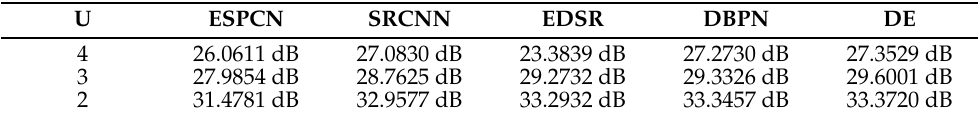
Table 3. Comparison of different methods using the Inria aerial dataset. Among them, ESPCN and our DE module were mentioned above; their PSNR values are also listed here. U ESPCN SRCNN EDSR DBPN DE 4 26.0611 dB